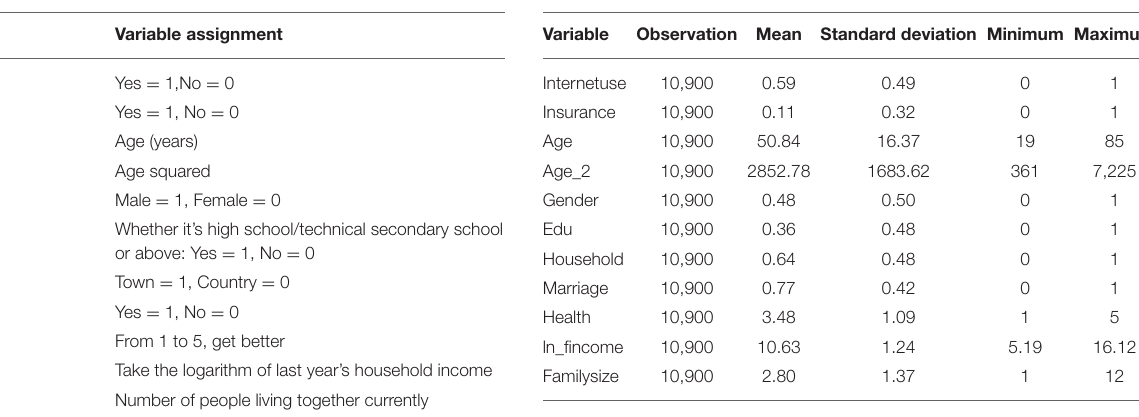
TABLE 2 | Descriptive statistics of